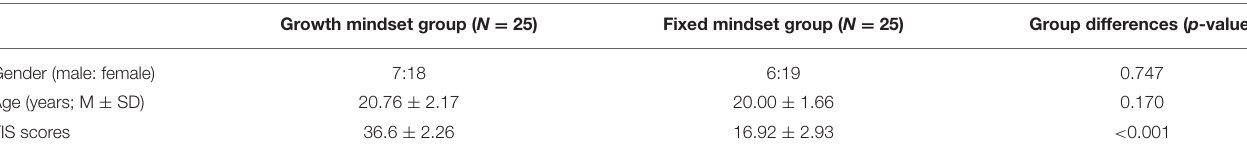
TABLE 1 | Characteristics of participants. Growth mindset group ( N = 25) Fixed mindset group ( N =